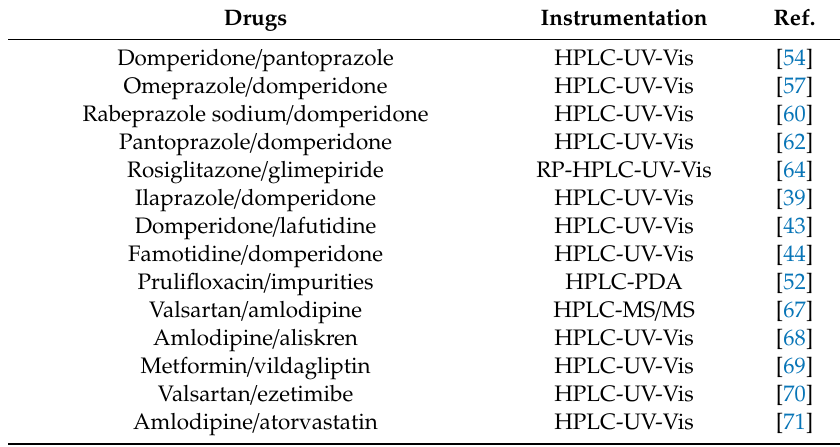
Table 1. High performance liquid chromatography (HPLC) procedures developed and validated for binary drug-association co-formulations analyses in